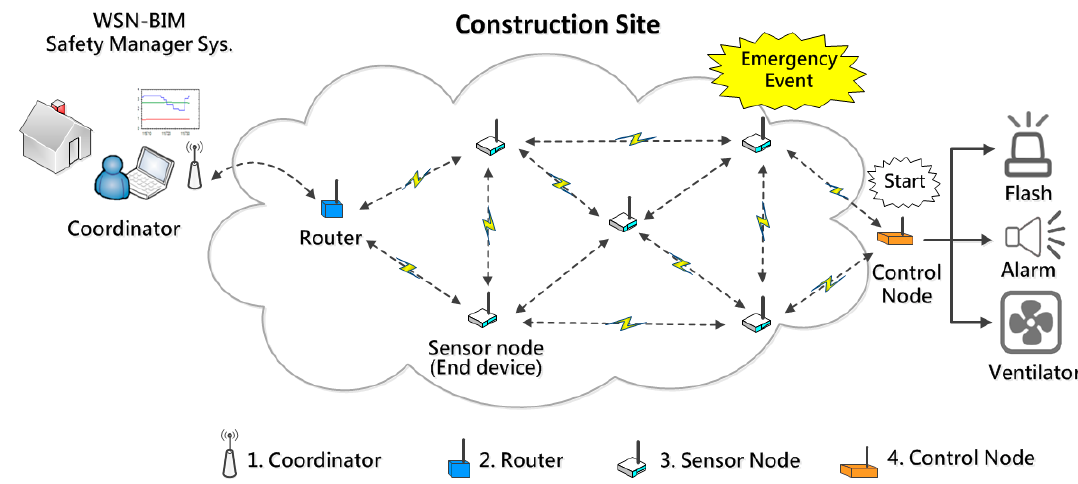
Figure 4. The mesh topology of the proposed WSN system.